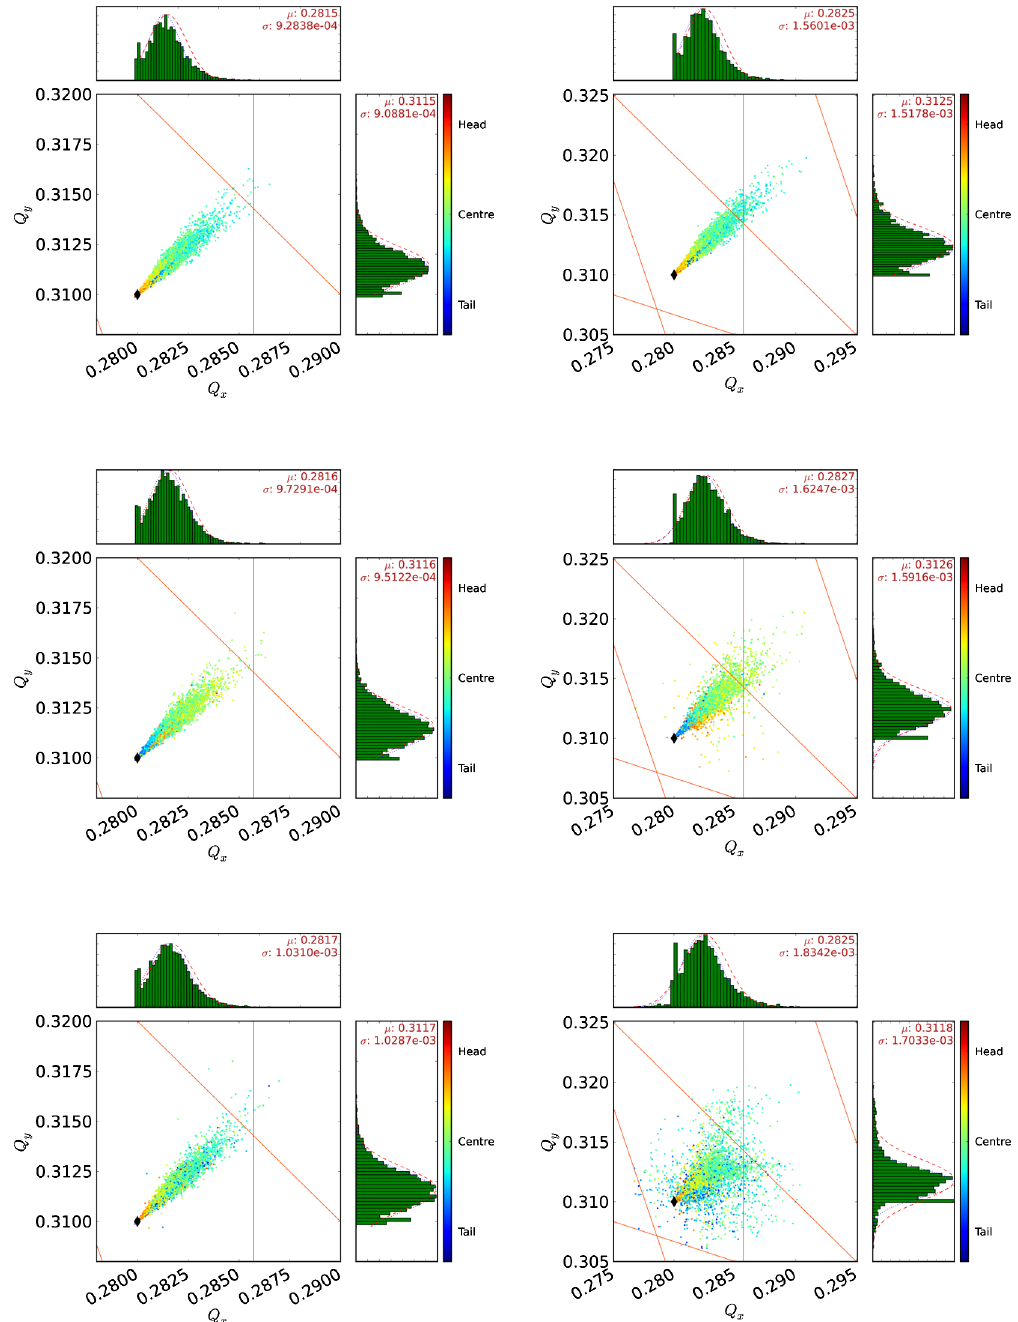
FIG. 23. Tune footprint snapshots in a straight section at 3.5 TeVafter 1 = 16 (top), 1 = 2 (middle), and 1 (bottom) synchrotron periods. Left: Below the instability threshold ( (cid:6) c ¼ 3 : 1 (cid:2) 10 11 m (cid:1) 3 , n b ¼ 1 : 15 (cid:2) 10 11 ppb ). Right: Above the intensity threshold ( (cid:6) c ¼ 5 : 2 (cid:2) 10 11 m (cid:1) 3 , n b ¼ 1 : 15 (cid:2) 10 11 ppb ). Resonance lines up to 11th order have been included. their initial longitudinal positions along the bunch. Blue through the electron cloud. Along with this, the projec- resembles particles towards the tail; red are particles tions onto each axis are plotted as histograms. The sta- towards the head of the bunch. It becomes evident how tistical moments corresponding to the incoherent tune shift and tune spread are evaluated for each histogram and the corresponding Gaussian curve is sketched in red nied by growing nonlinear fields as the bunch passes just for orientation.